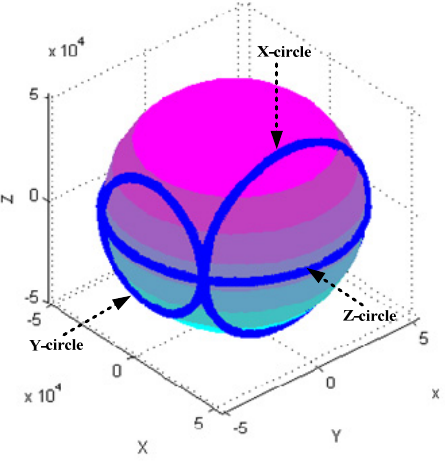
Figure 4. Optimal ellipsoid fitting (EF1).